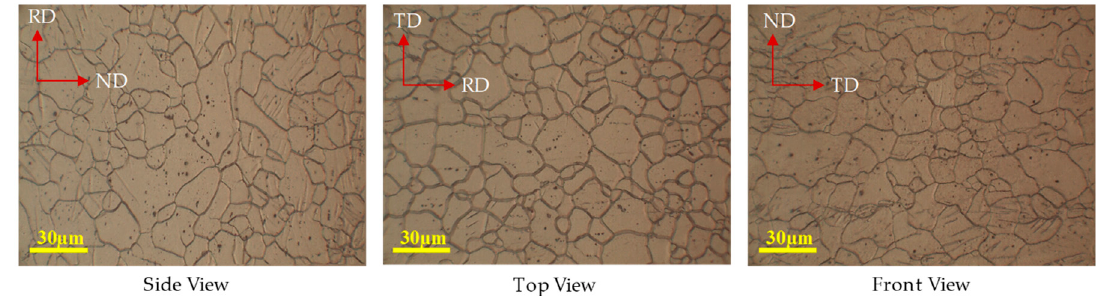
Figure 18. Initial microstructure of as-received magnesium alloy sheet AZ31B.